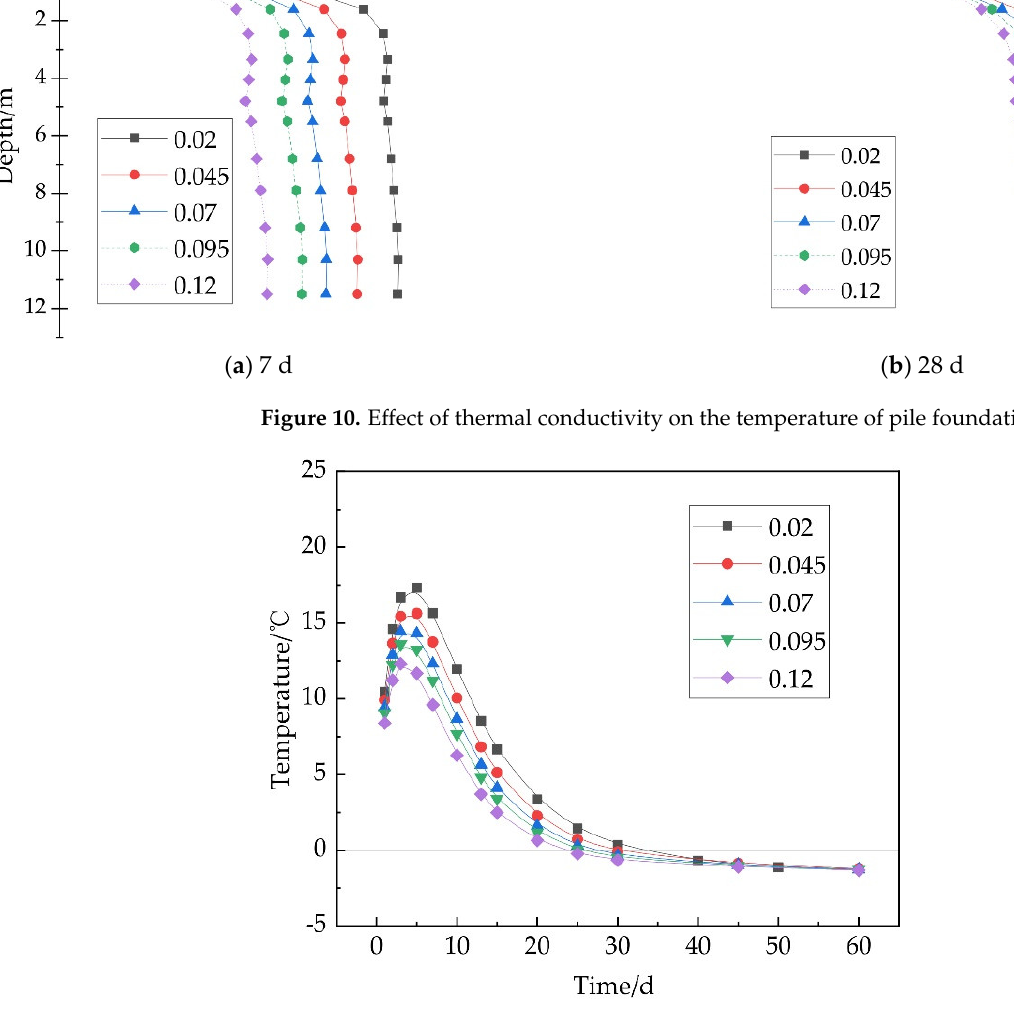
Figure 11. Pile body temperature with different thermal conductivities from 0–50 d.